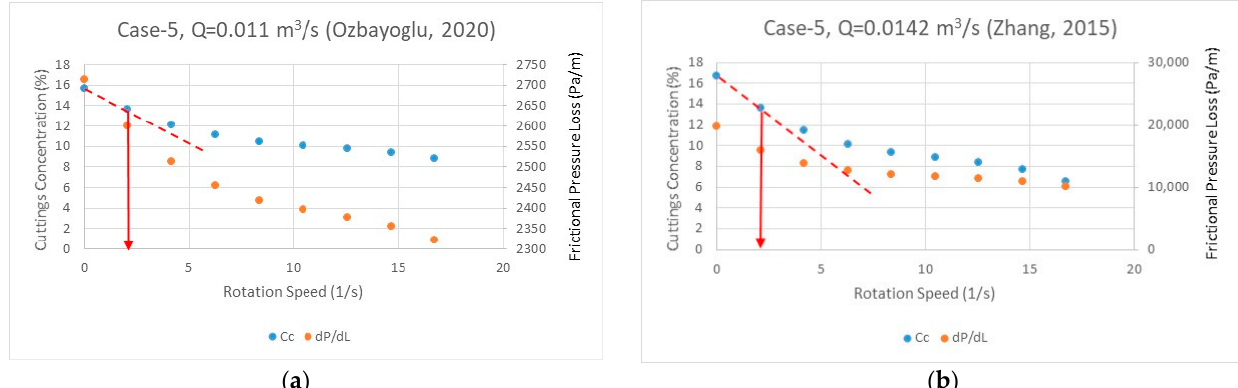
Figure 11. Determination of the optimal pipe rotation speed after the optimal flow rate is determined for Case 5: ( a ) Ozbayoglu’s model and ( b ) Zhang’s model.